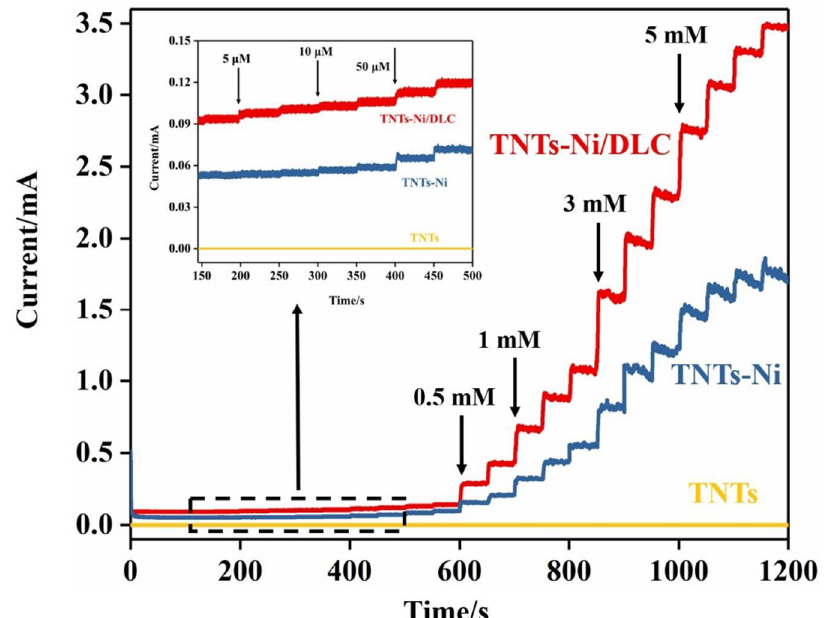
Figure 7. The i-t curves of the TNT electrode, Ni/TNT electrode, and Ni-DLC/TNT composite electrode when different concentrations of glucose solution were continuously added. The illustration shows the enlarged view at low concentrations.